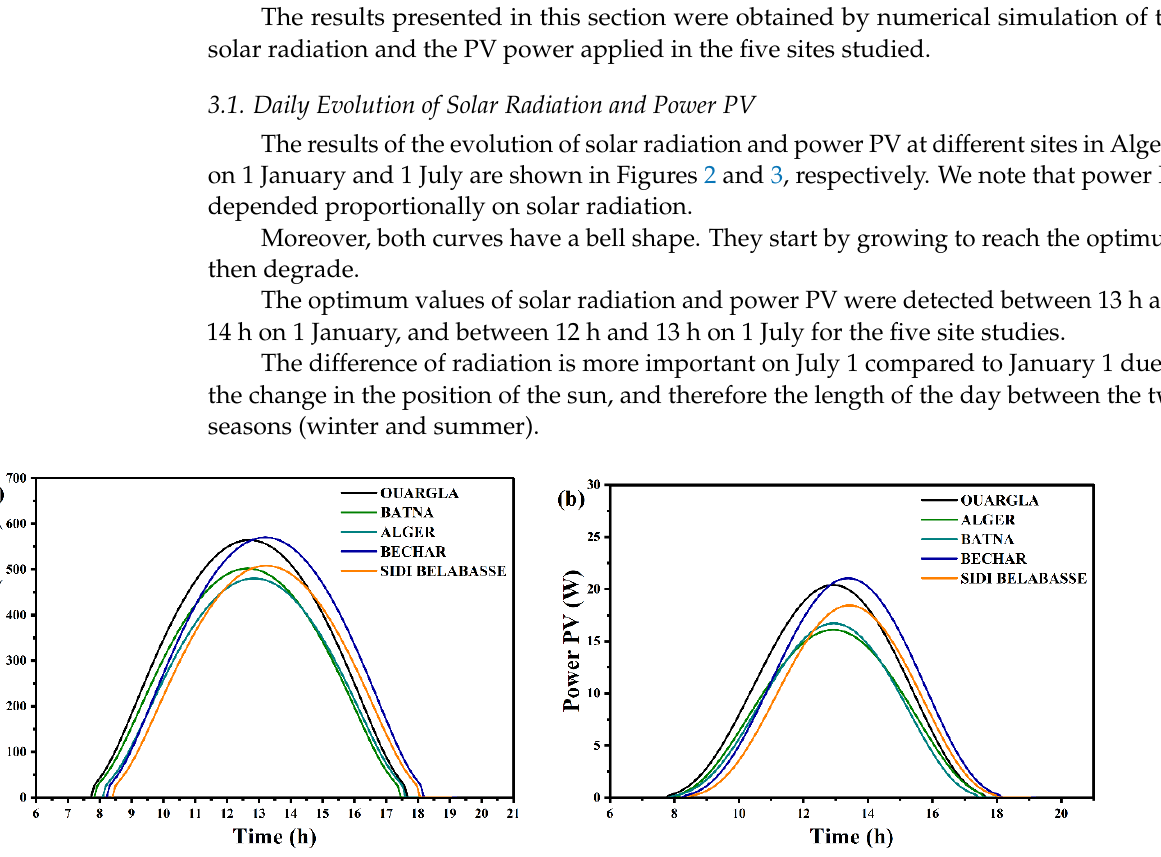
Figure 2. Daily evolution of ( a ) solar radiation and ( b ) power PV at different sites in Algeria (1 January 2022).